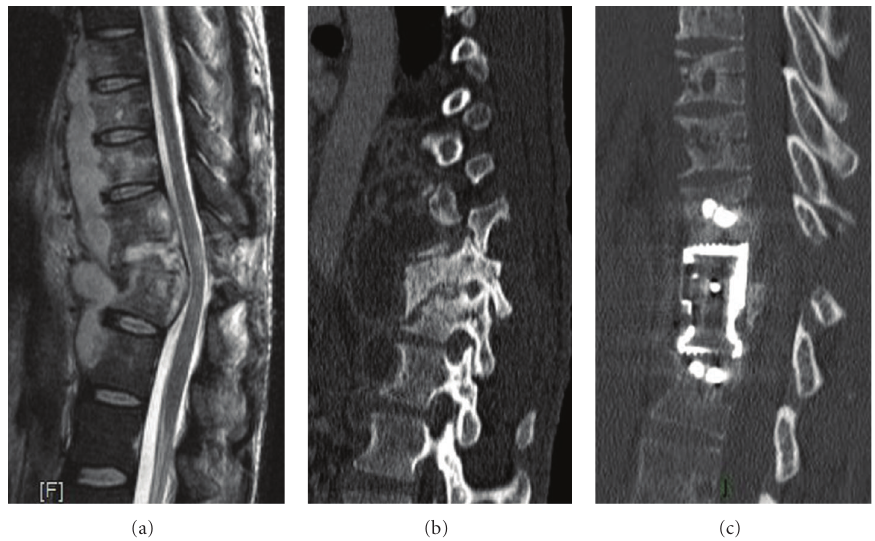
Figure 3: (a) Sagittal MRI T2: here the infectious process has involved two vertebral bodies with an initial tightening of the canal even if it is still possible to identify signs of the liquor around the spinal cord. The paravertebral extension is clearly visible. (b) Sagittal CT: it highlights the marked kyphotic deformation caused by the complete erosion of the bone by the infection, in particular to the inferior vertebral body. (c) Postoperative sagittal CT: highlighted here is the correct positioning of the mesh as well as the restitution of the correct curvature to the dorsal rachises.